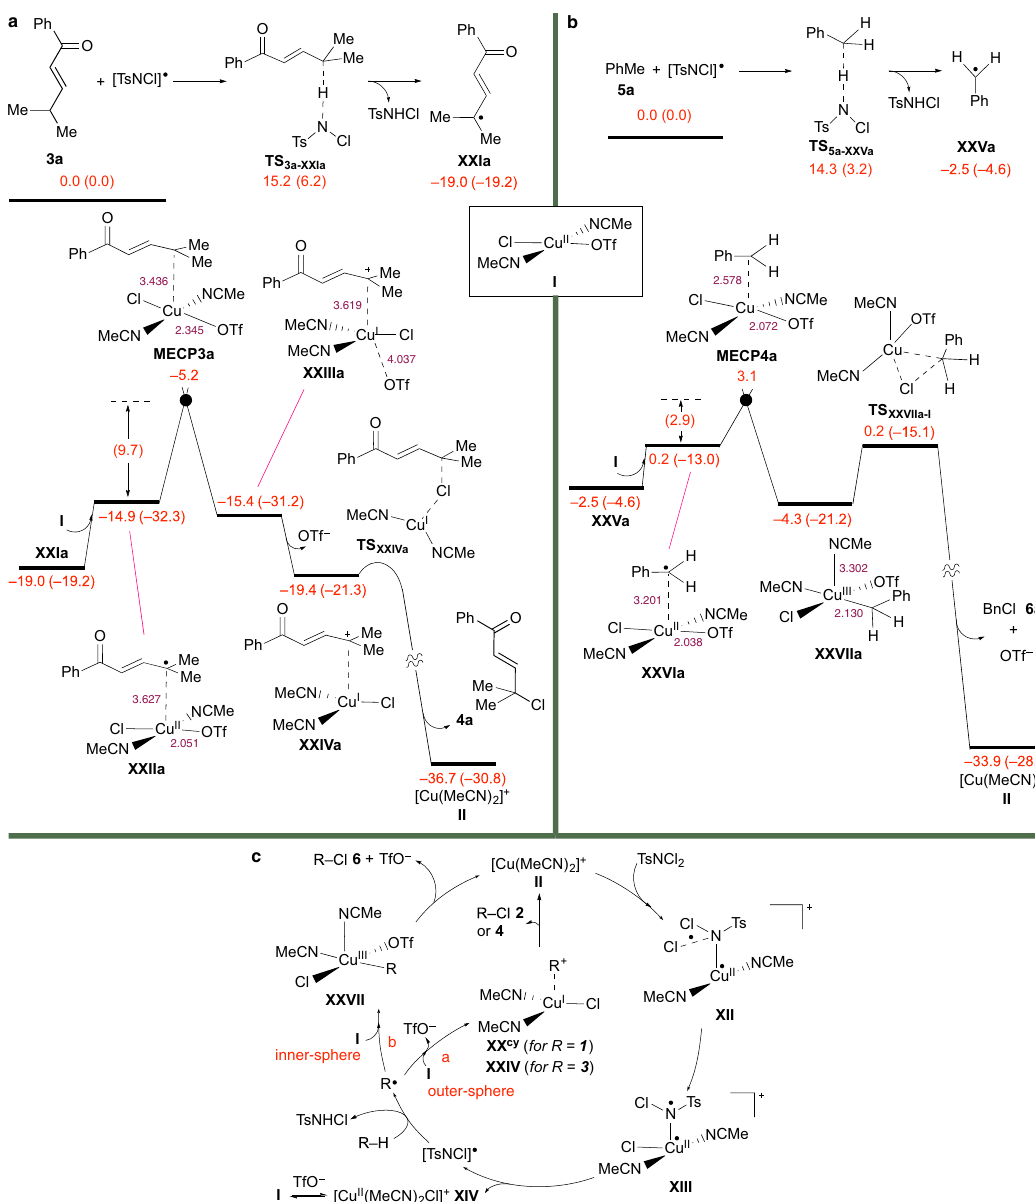
Fig. 5 DFT calculations and proposed reaction mechanism. Energy pro fi les for the chlorination of a XXIa to 4a from 3a and [TsNCl] • motif; and b XXVa to 6a from 5a and [TsNCl] • motif. The relative Gibbs free energies and potential energies (in parentheses) obtained from SMD/ B3LYP-D3/def2-TZVP//SMD/B3LYP-D3/6-31G( d , p ),SDD calculations are given in kcal/mol (red) and bond lengths in A ̊ (purple). c Proposed catalytic